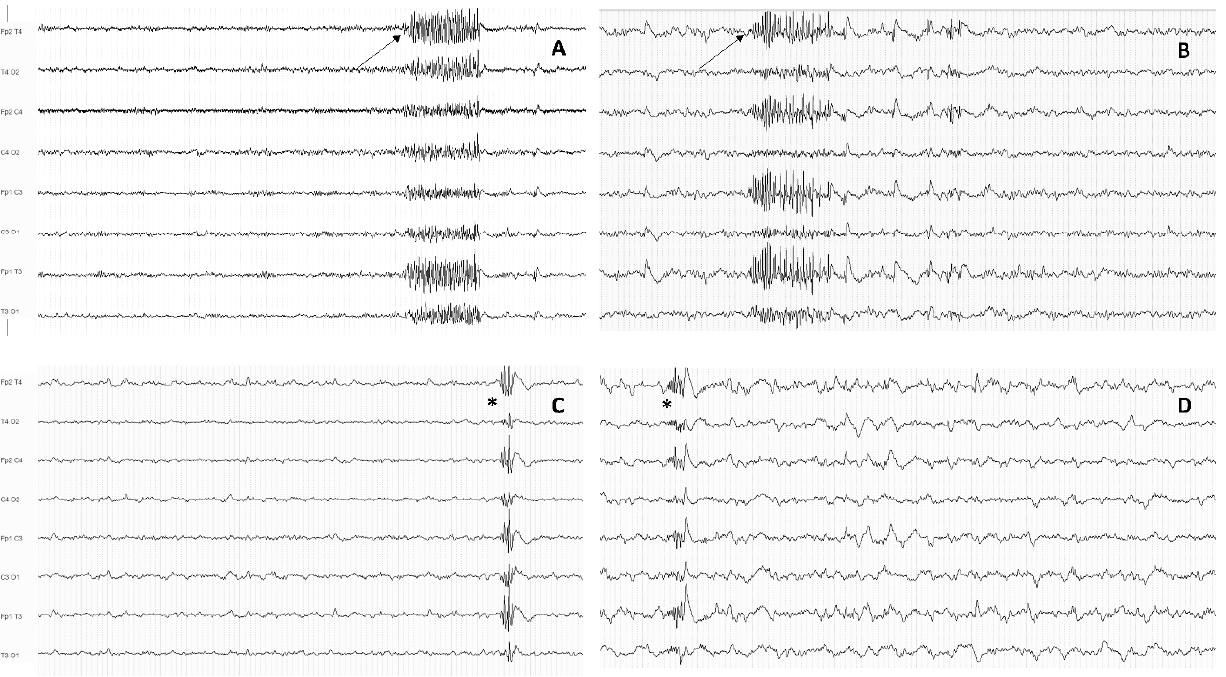
Figure 3. Examples of generalized paroxysmal fast activity (GPFA) and generalized polyspike train (GPT). Panel ( A , B ): examples of GPFA (black arrow); Panel ( C , D ): Examples of GPT (asterisk).